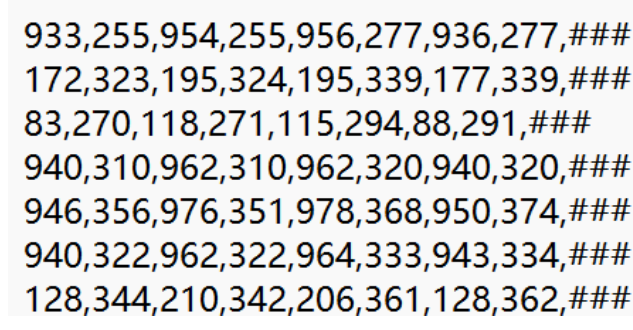
Figure 8. Text format tags used in DBNet dataset training.